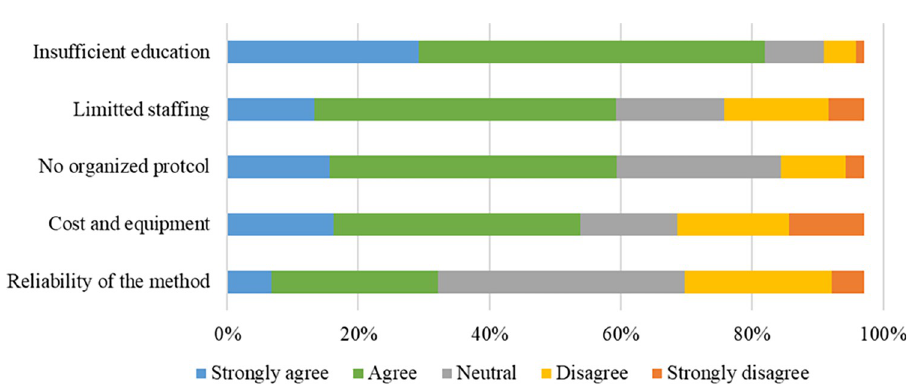
Fig 2. The barriers for implementing ultrasound-based muscle mass assessment. The barriers were assessed using a 5-point Likert scale with “Strongly agree” and “Agree,” which were used for the comparison.